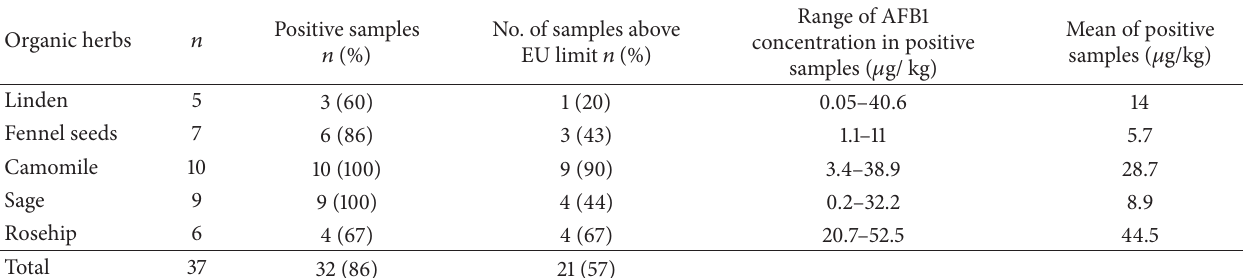
Table 2: Aflatoxin B1 content of organic herb